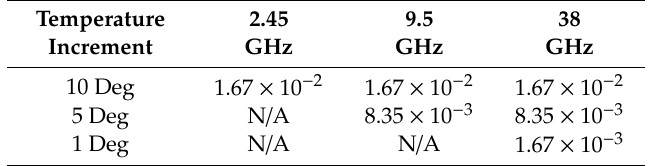
Table 5. Dielectric constant change over temperature sweep (measured results ∆ ε r